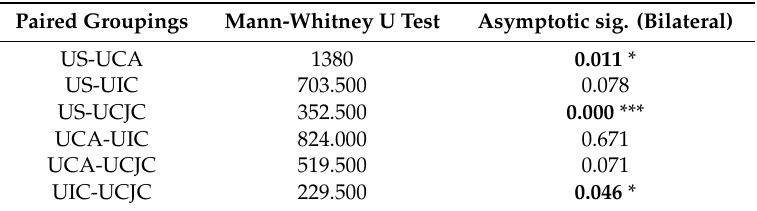
Table 10. Mann-Whitney U